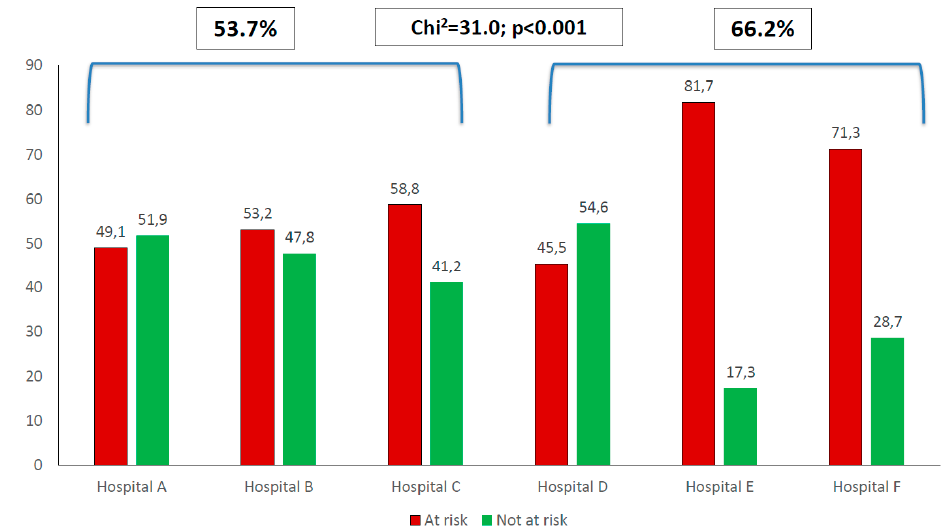
Figure 1. Proportion of patients at risk of malnutrition on admission per hospital.